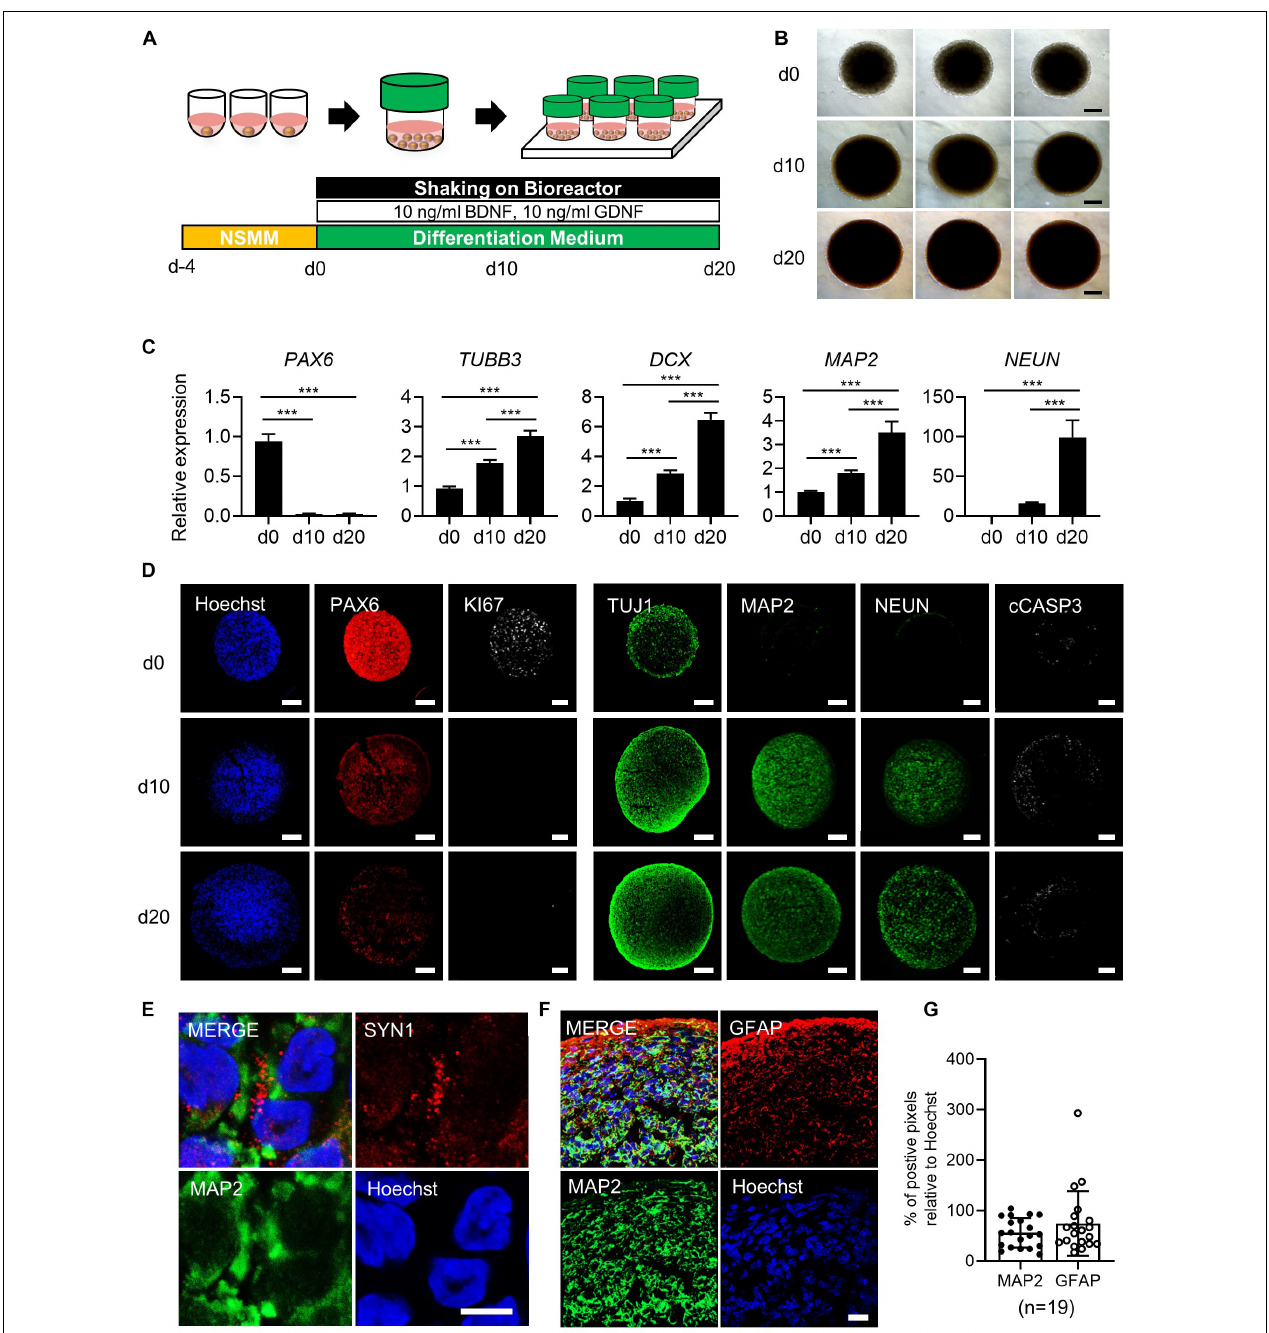
FIGURE 1 | Generation of simplified brain organoids (simBOs) from human primitive neural stem cells (pNSC). (A) Graphical schematics for the generation of pNSCs into simBOs. (B) Phase contrast images of simBOs at days 0, 10, and 20 of spontaneous differentiation. Scale bars represent 200 µ m. (C) Quantitative reverse transcription polymerase chain reaction (qRT-PCR) analysis for neural progenitor ( PAX6 ) and neuronal ( TUBB3 , DCX , MAP2 , and, NEUN ) markers in simBOs at days 0, 10, and 20 of spontaneous differentiation. Expression value was normalized to those of day 0 (d0). Data represent mean ± standard error (SE) from three technical replicates. Statistical significance of Turkey’s multiple comparisons *** p < 0.001 after one-way ANOVA. (D) Immunofluorescence analysis of simBOs with proliferating neural progenitor markers (PAX6 and Ki67), neuronal markers (TUJ1, MAP2, and NEUN), and apoptotic cell marker (cleaved caspase III; cCASP3) at indicated times. Scale bars represent 100 µ m. (E) Immunofluorescence analysis of simBOs with a mature neuronal marker (MAP2) and a synaptic marker (SYN1) in simBOs after day 10 of spontaneous differentiation. Scale bar represents 5 µ m. (F) Immunofluorescence analysis of simBOs with mature neuronal marker (MAP2) and astroglial cell marker (GFAP) after day 10 of spontaneous differentiation. Scale bar represents 20 µ m. (G) Quantitative graph of the percentage (%) of positive pixels of each marker relative to Hoechst. Data represent mean ± standard error (SE) ( n = 19). No significant differences were observed.